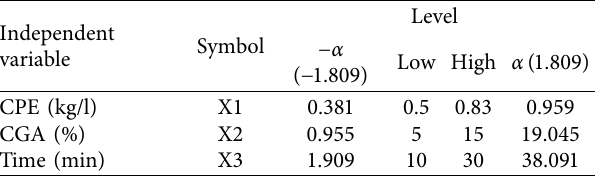
Table 2: Level of independent variables used for the center composite design (CCD).